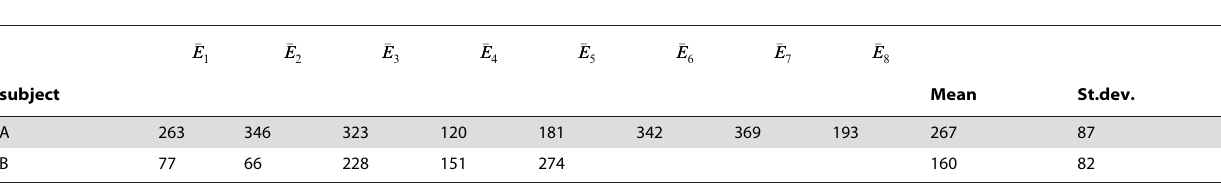
[cal day 2 1 ] of the effect of dieting upon the drive D . Table 2. Mean value (cid:2) EE i